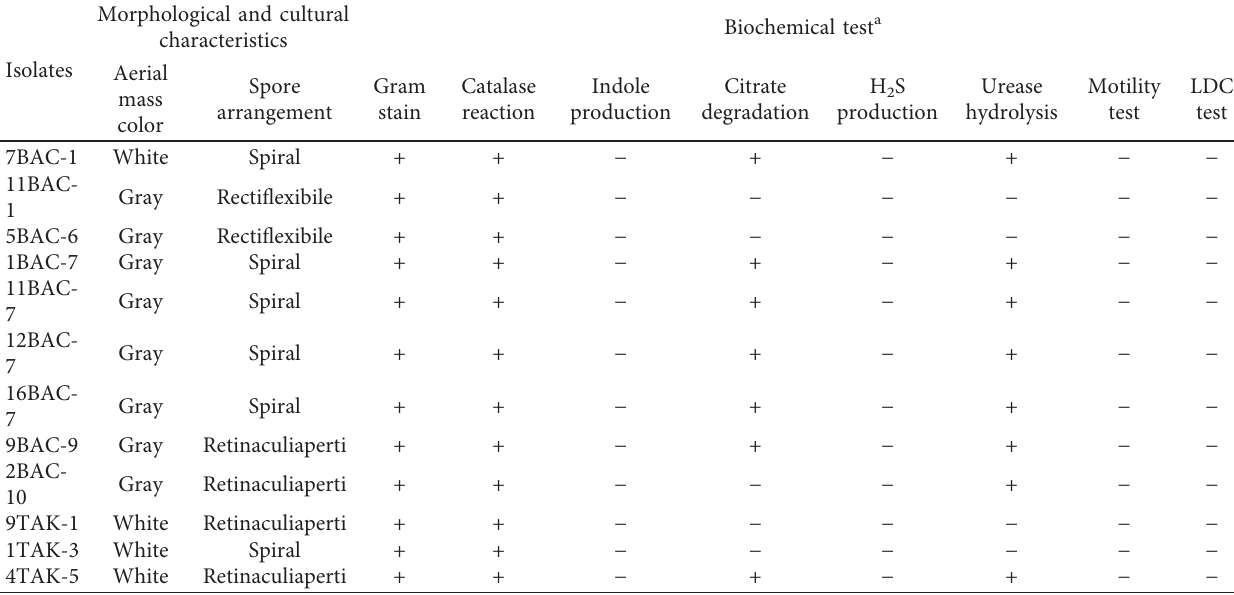
Table 3: Morphological features and biochemical characteristics of presumptive Streptomyces isolates.